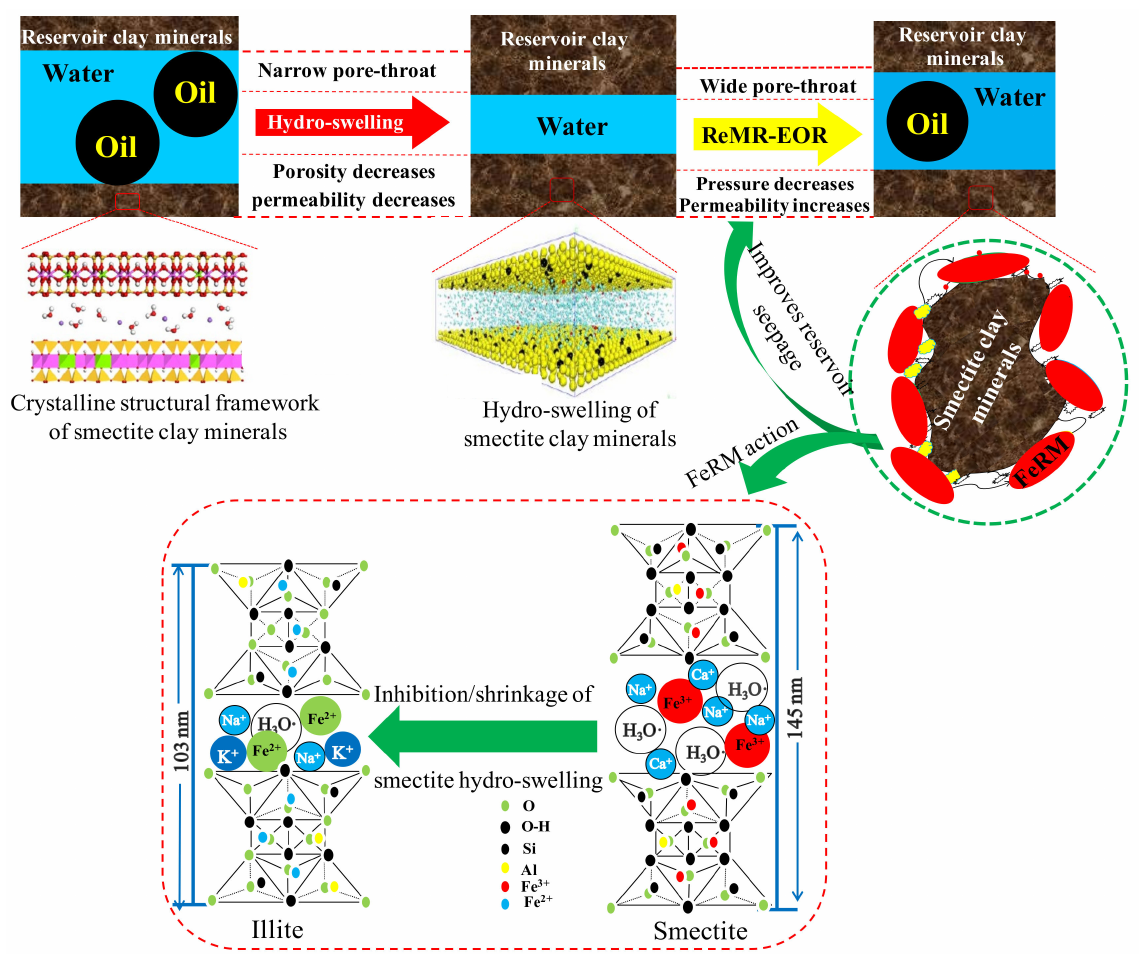
Figure 6. The biochemical process of swelling reduction, injection augmentation, and oil recovery enhancement of the low-permeability reservoirs by